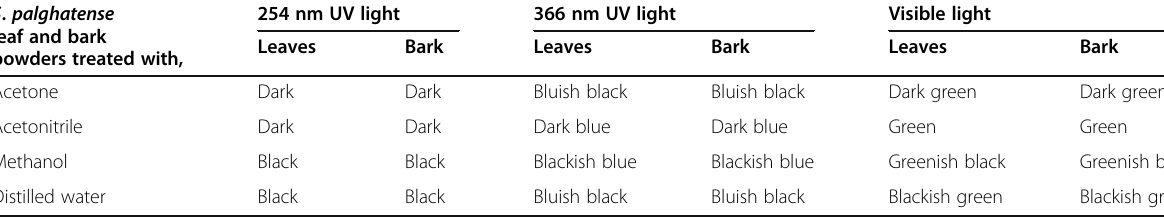
Table 1 Fluorescence analysis of S . palghatense leaves and bark S . palghatense leaf and